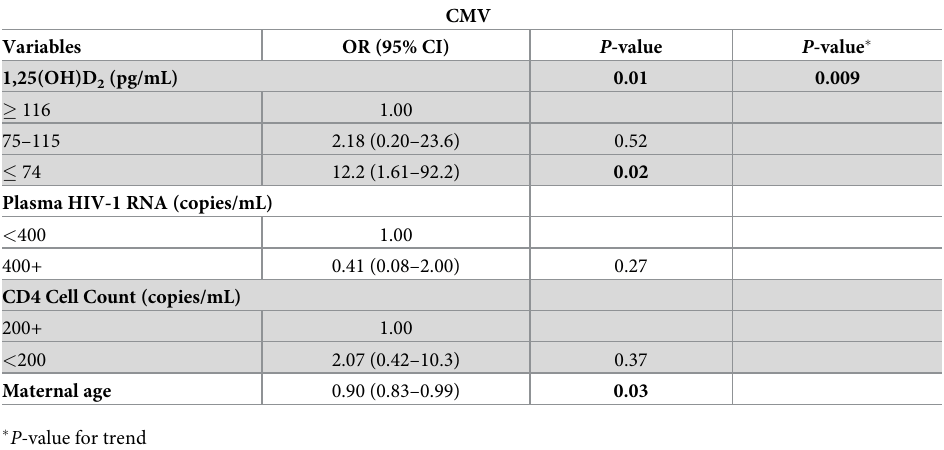
Table 4. Factors associated with congenital CMV in multivariate model A.